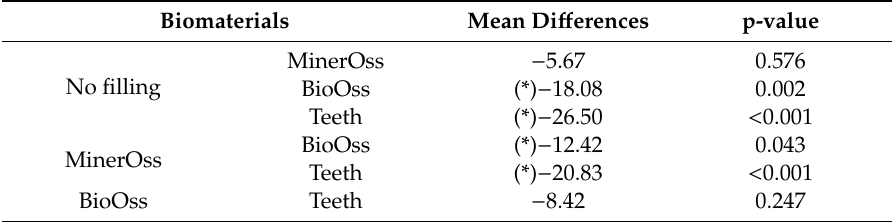
Table 3. Tukey’s HSD test. Based on the means observed according to the filling material. (*) The di ff erence in means is significant at the 0.05 level.